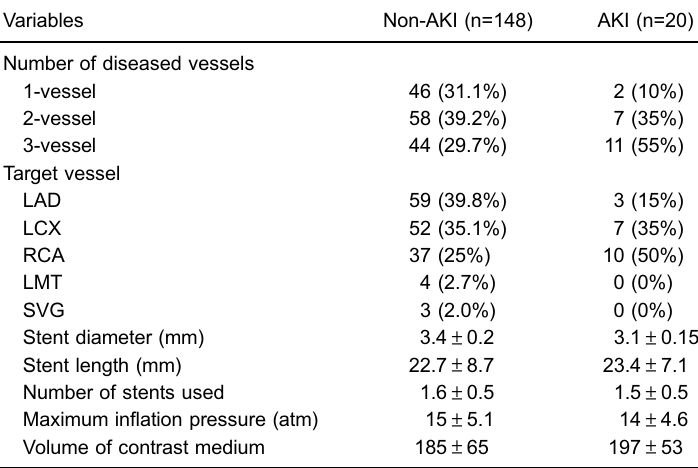
Table 2. Angiographic results and lesion features of patients with or without acute kidney injury (AKI).